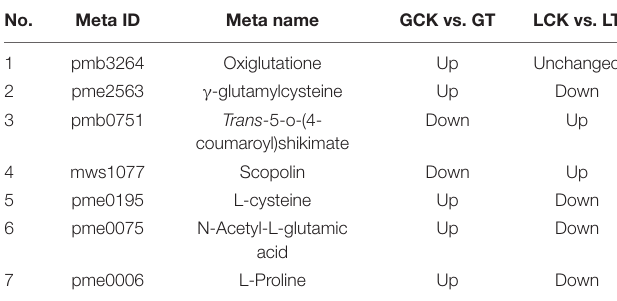
TABLE 6 | Regulation of metabolites in the two samples under atrazine stress. No.